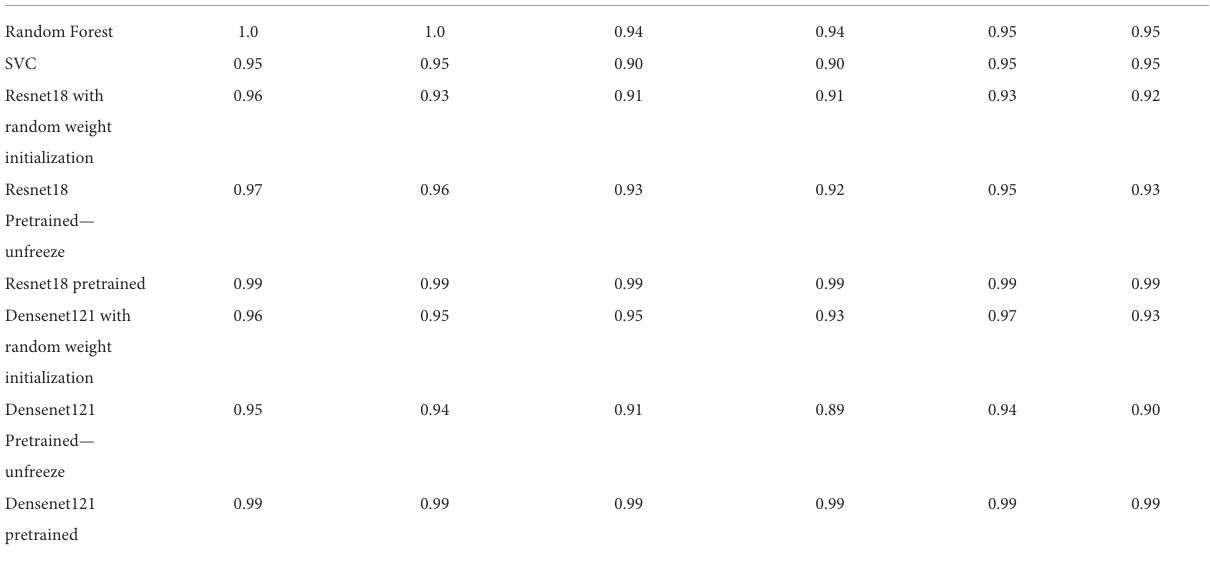
TABLE 2 Quantitative comparison of ML-based classification models for saffron classification based on accuracy and precision.